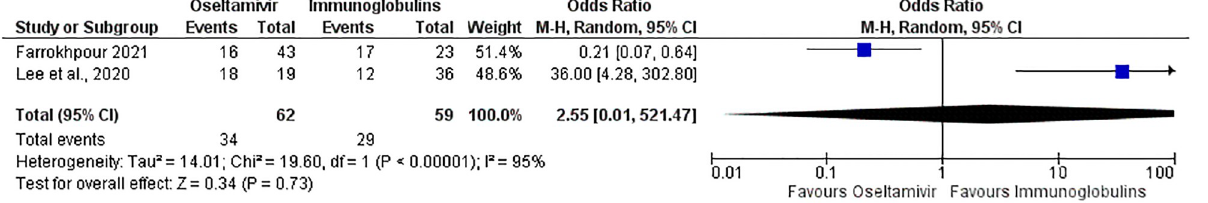
Fig 5. Forest plot. Shows the meta-analysis comparing the survival of the oseltamivir group to the Immunoglobulins group.